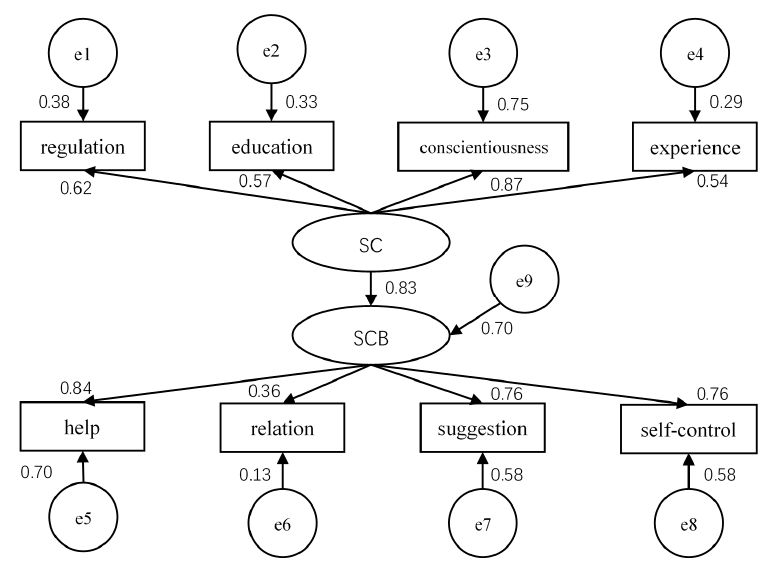
Figure 1. Structural equation model of safety consciousness and safety citizenship behaviour. Table 12. Fit criteria of SEM (structural equation model).